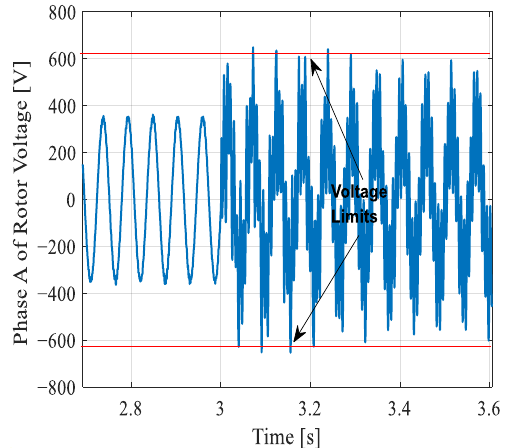
Figure 21. Rotor voltages in phase A during an unbalanced voltage sag of 70%.